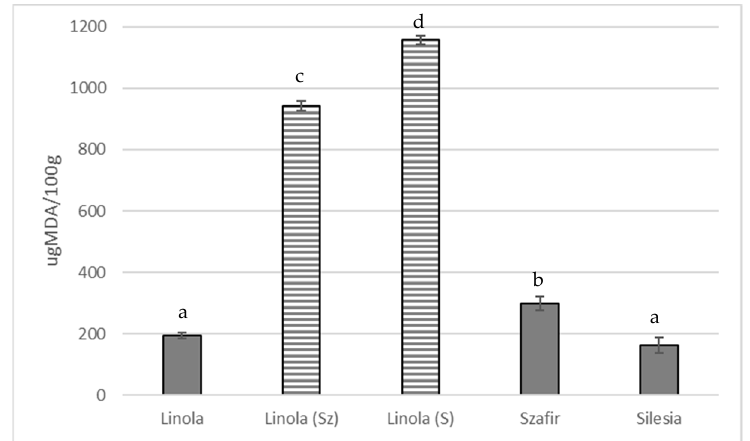
Figure 2. Analysis of MDA content after supplementation of Linola oil with linoleic acid to reach the levels characteristic for Szafir and Silesia oils (Linola (Sz) and Linola (S), respectively). The results typical for unattached Linola, Szafir and Silesia oils are given for comparison. All results are statistically significant ( p < 0.05). Different superscripts imply significant differences.